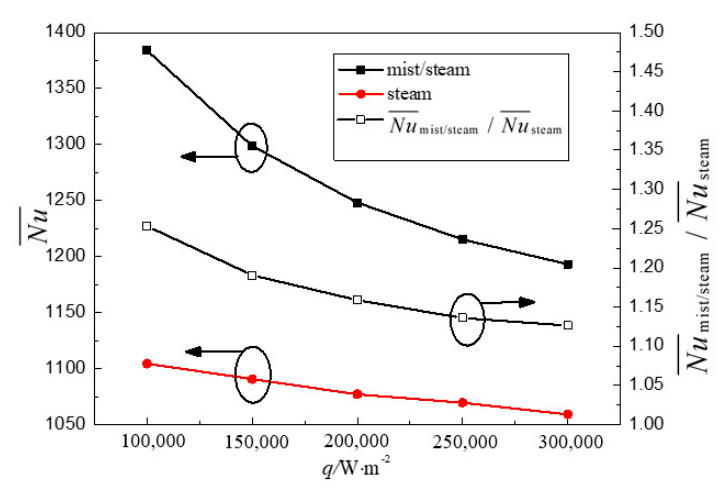
Figure 14. Variation in the average Nusselt number of the ribbed surface of mist/steam and steam cooling channels with the wall heat flux density.